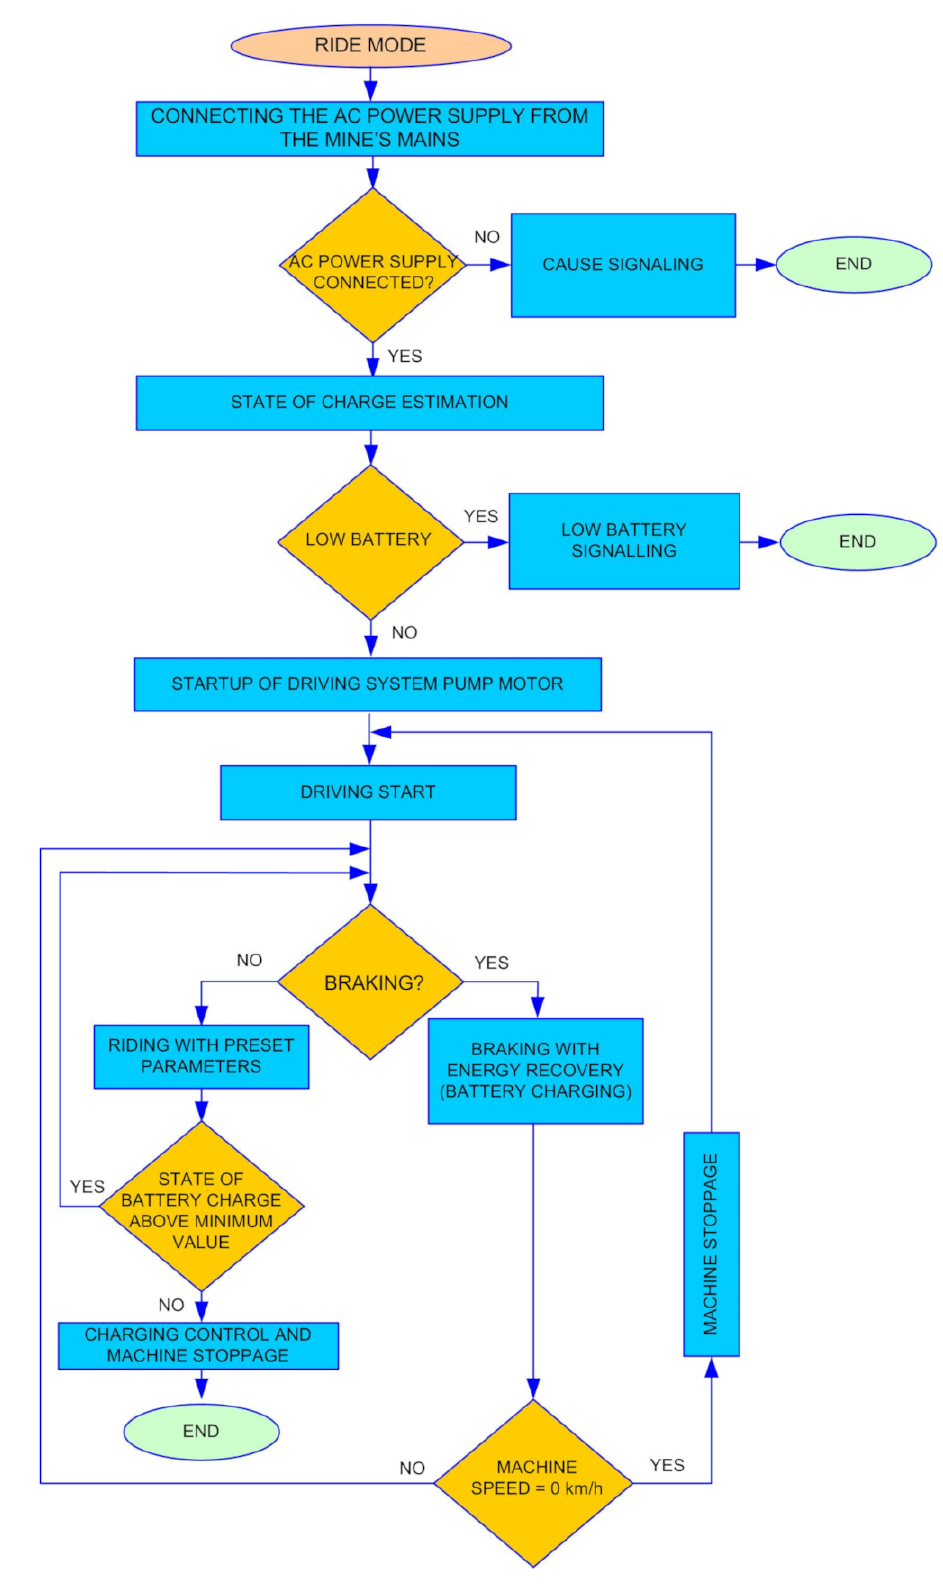
Figure 8. Algorithm controlling the electric power system during the ride. The algorithm for controlling the electric power system during operation is shown in Figure 9. After switching on the voltage in accordance with the procedure